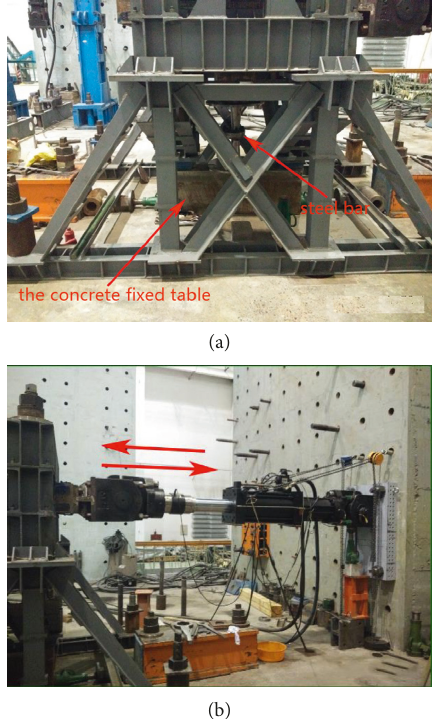
Figure 6: Installed experimental device. (a) Test installation completion diagram and (b) MTS 244.41 servo